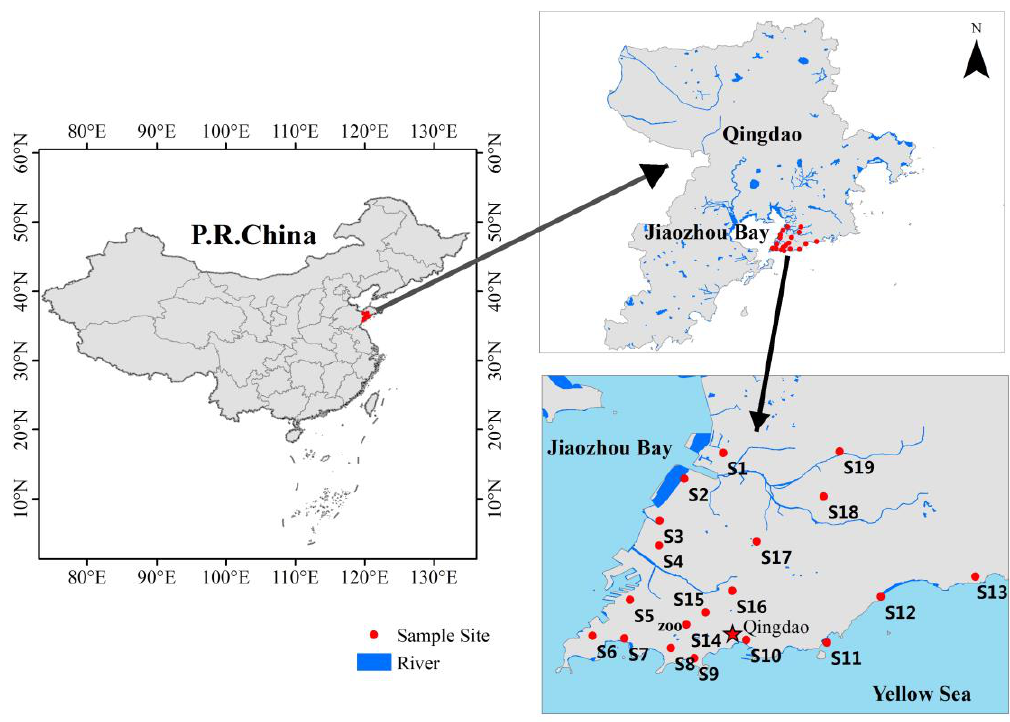
Figure 1. Locations of the sampling sites.